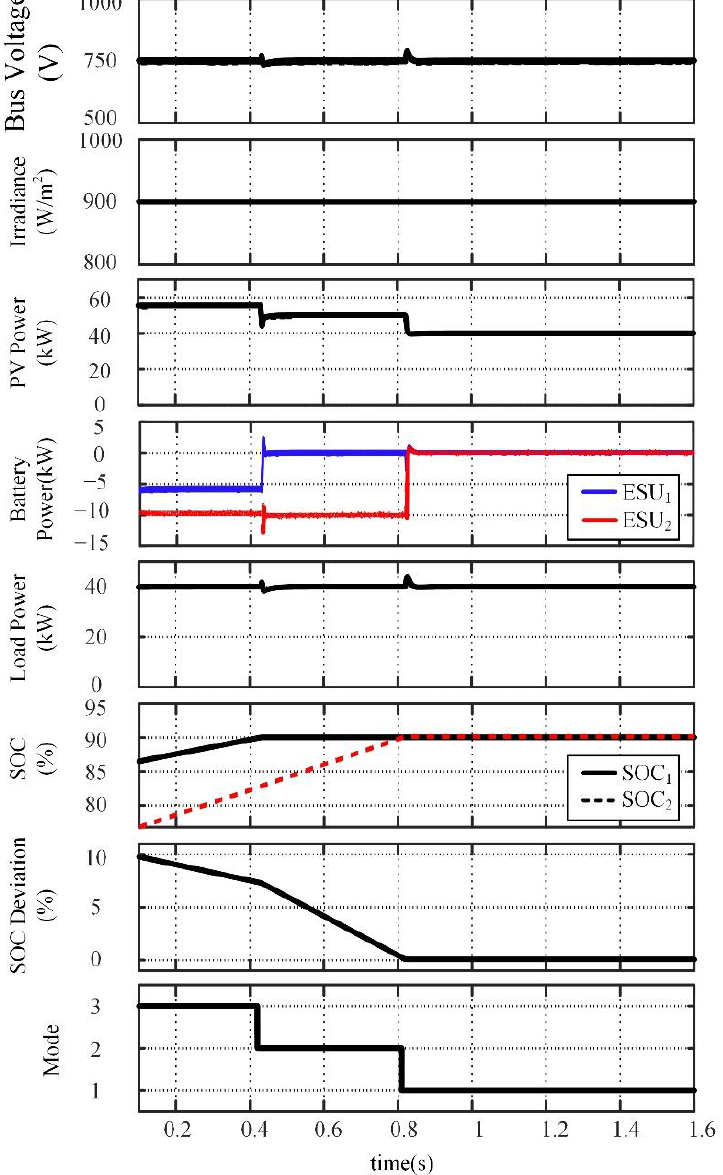
Figure 11. Response to sudden change of PV power.